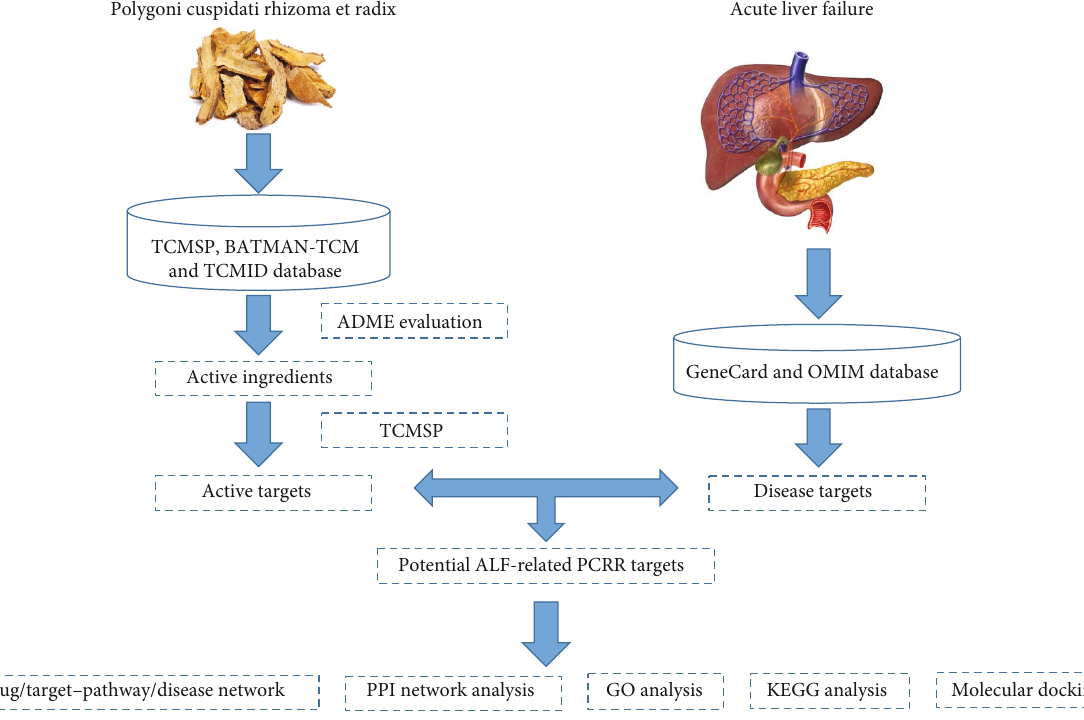
Figure 1: Detailed fl owchart of the study design. Table 1: Active pharmaceutical components of PCRR.